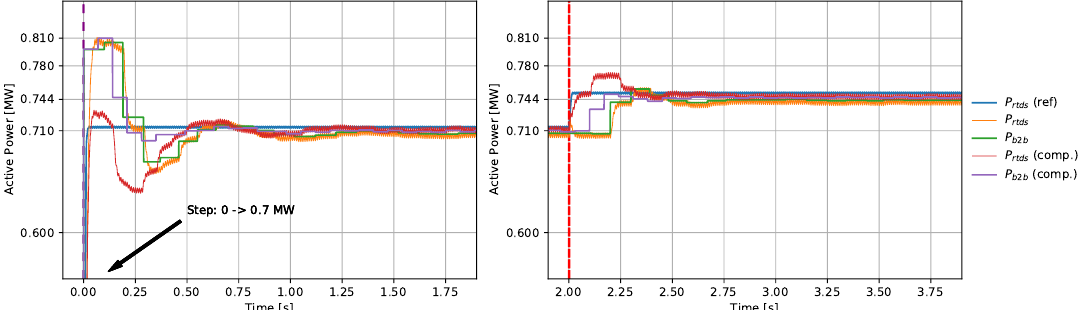
Figure 12. Inset graphs of voltage response during closed-loop test: DL step ( left ); and OLTC tap change ( right ).